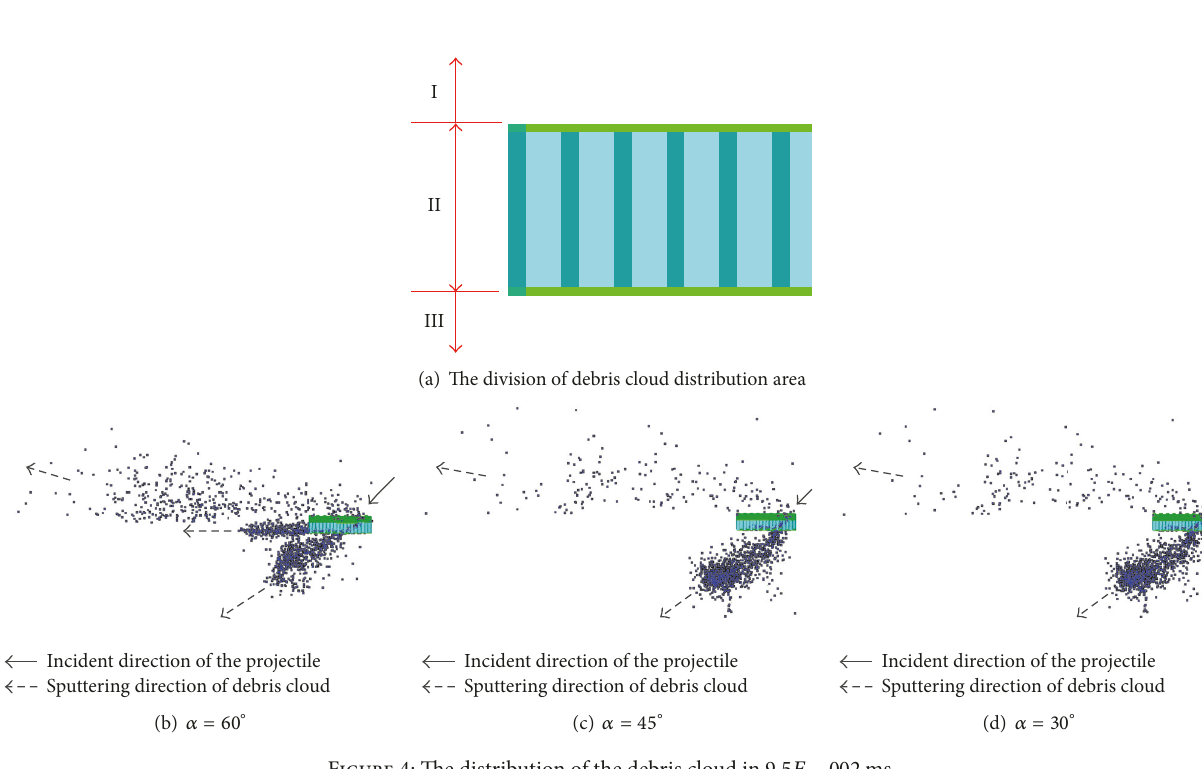
Figure 4: The distribution of the debris cloud in 9.5𝐸 − 002